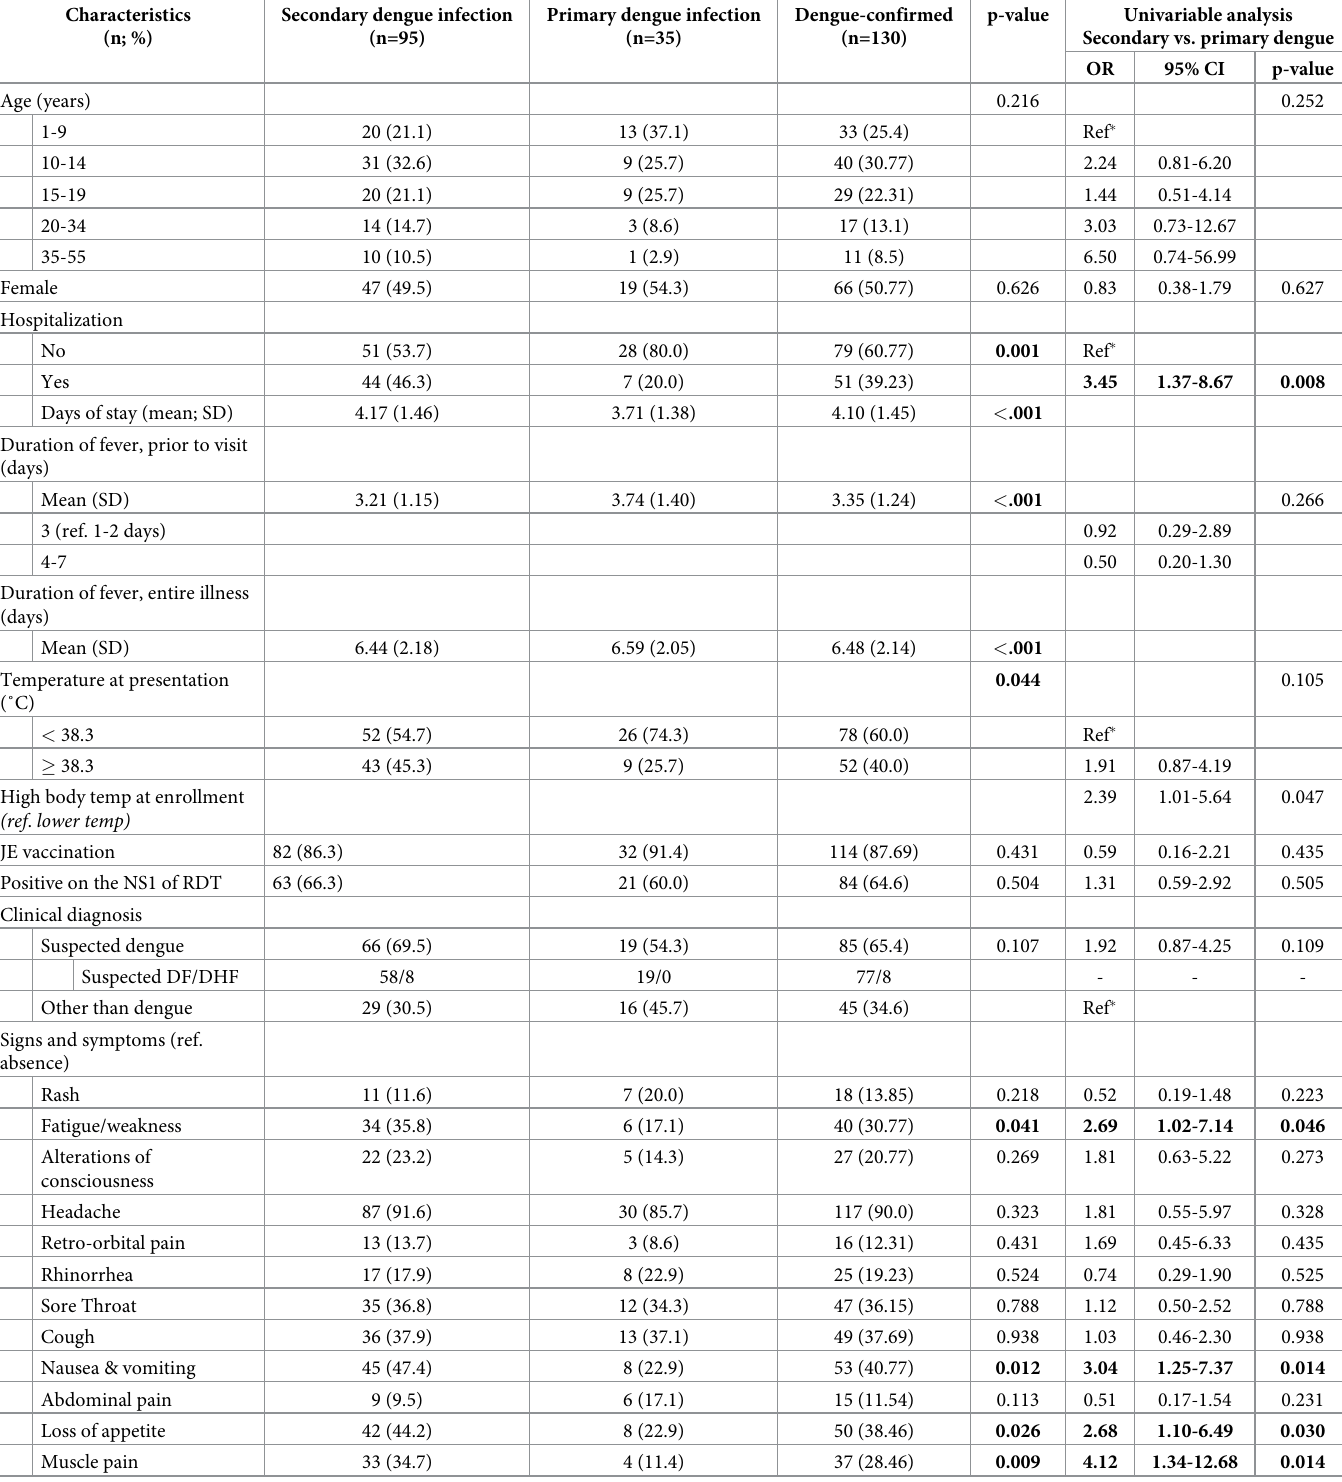
Table 4. Demographic and clinical characteristics of patients with secondary vs. primary dengue infection among the dengue-confirmed cases from the health facil- ity-based fever surveillance established in Bang Phae district, Ratchaburi province, Thailand in